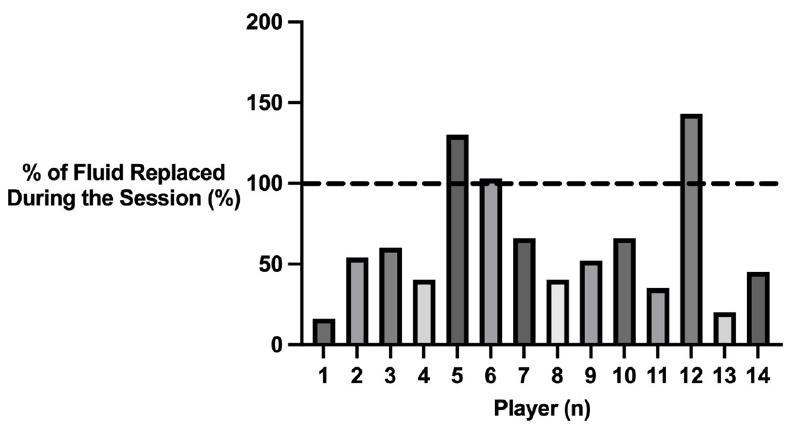
Figure 3. % of fluid replaced by each player during the training session. Dotted line denotes 100% of fluid replaced during the session.